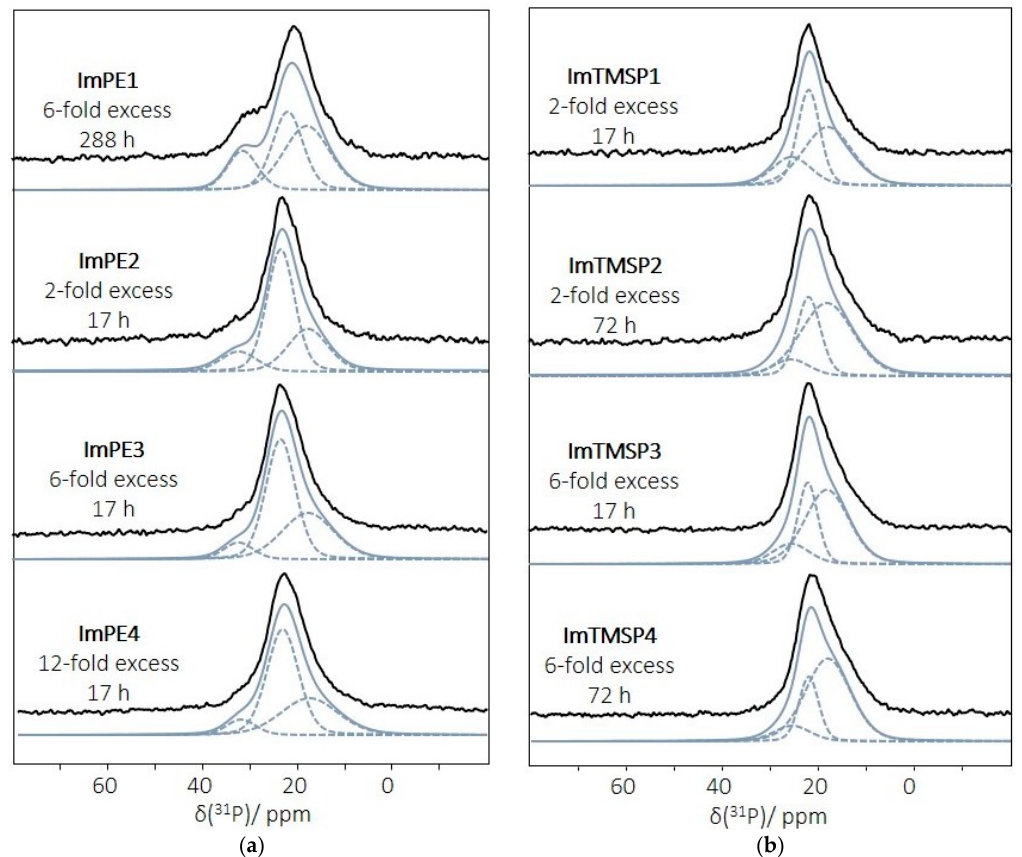
Figure 5. 31 P MAS NMR spectra of γ -Al 2 O 3 grafted samples prepared under different reaction conditions: ( a ) standard conditions with ImPE (90 °C, 288 h) (ImPE1) and forcing conditions with